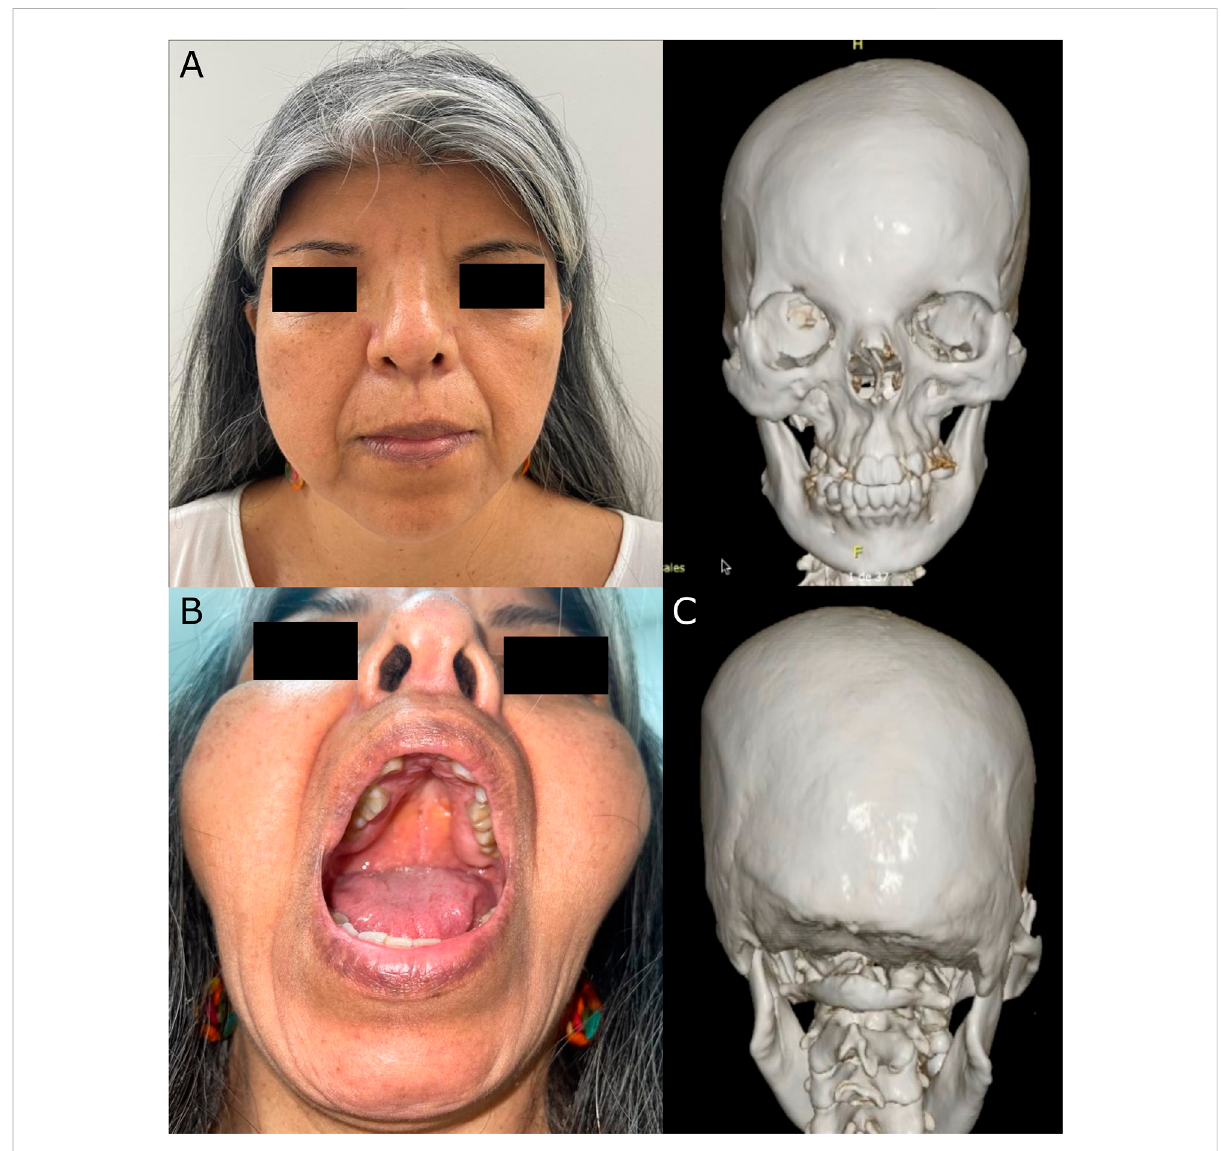
FIGURE 1 Cranial manifestations in the 54-year-old CFNS female patient. The fi gure shows (A) Facial dysmorphism (left) and frontal view of the 3D-CT showing facial asymmetry, dental crowding and the sinusoidal nasal septum with a large right bone spur (right); (B) high-arched palate, and (C) posterior view of the 3D-CT showing fl at occiput and left parietal bone